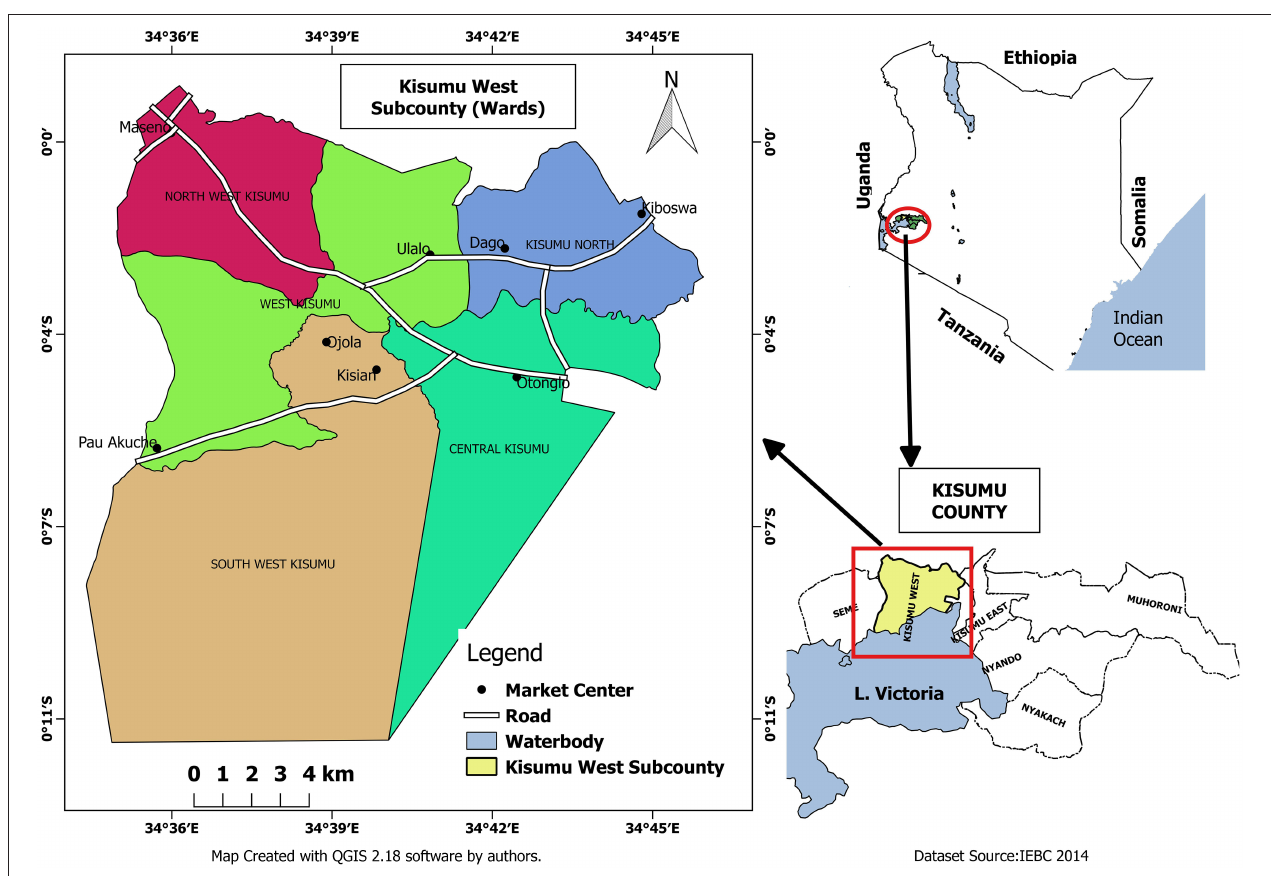
FIGURE 1 | Map of the study area.